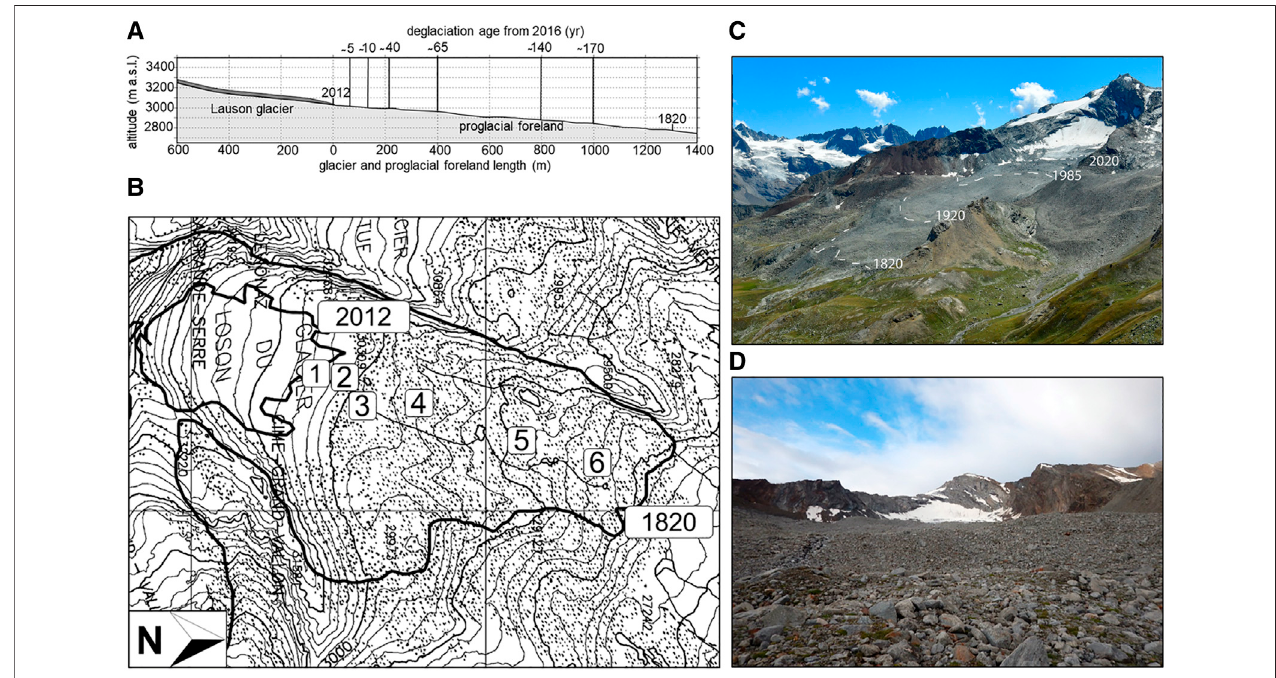
FIGURE1| RepresentationoftheLausonglacierforeland:elevationpro fi le (A) includingthelimitsofthereconstructedglacierretreat(1820 – 2012)andtheagefrom deglaciation of the six stages of the chronosequence; Regional Technical Map (B) with the positions of the stages of the chronosequence and the glacier terminus in 2012 and 1820; photo of the study area (C) with drawing of four known historical glacier terminus; photo of the oldest stage (D) deglaciated for ca. 170 years.